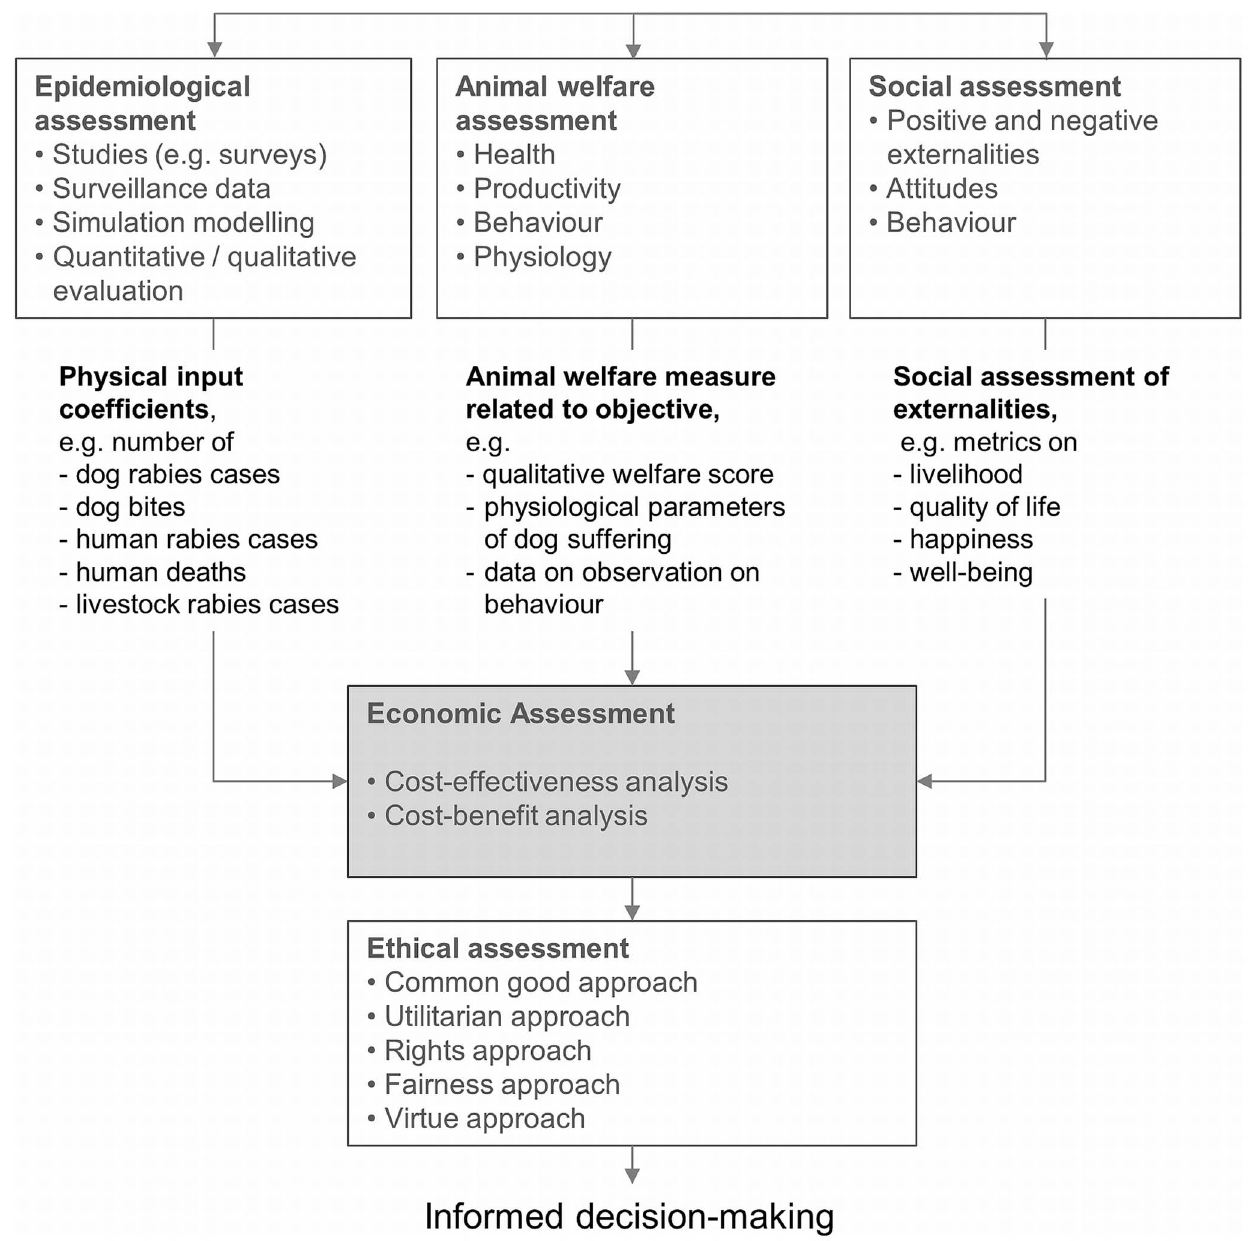
Figure 1. Overview of a conceptual integrated framework for the assessment of rabies control strategies. doi:10.1371/journal.pntd.0003270.g001 (CBA), where positive and negative aspects of a decision are